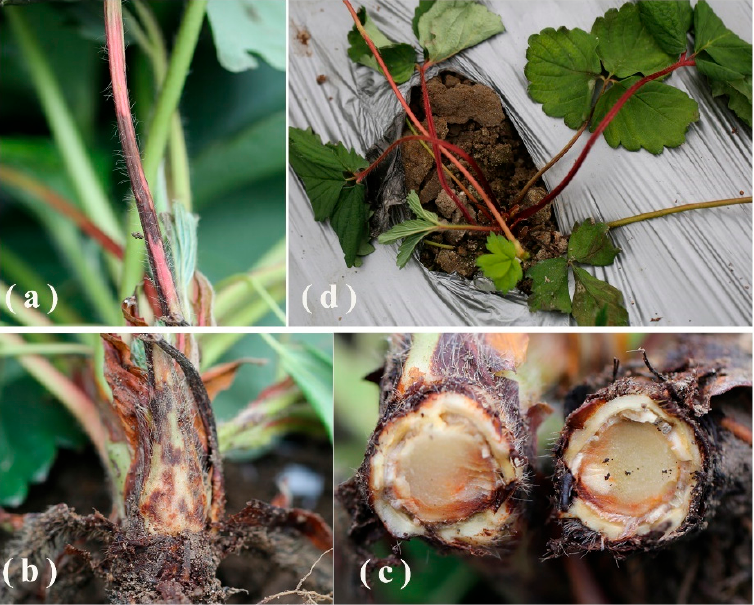
Figure 1. Anthracnose symptoms caused by Colletotrichum spp. in strawberry seedlings: ( a ) black spindle-shaped lesion on petiole; ( b ) irregular canker on stem; ( c ) crown rot; and ( d ) wilting.